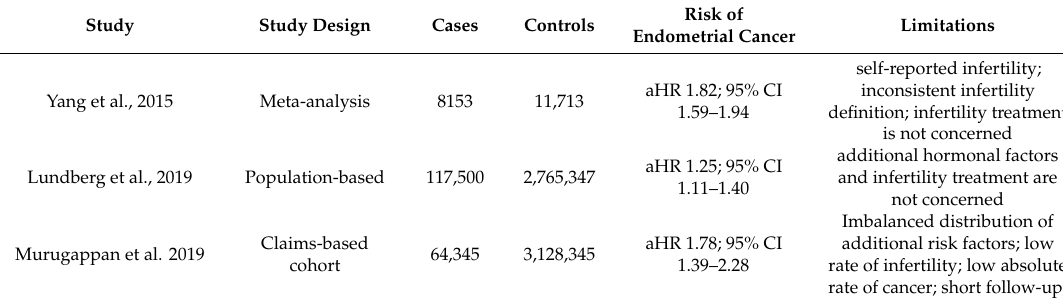
Table 1. Characteristics of the studies included in this review regarding infertility and endometrial cancer risk. aHR, adjusted hazard